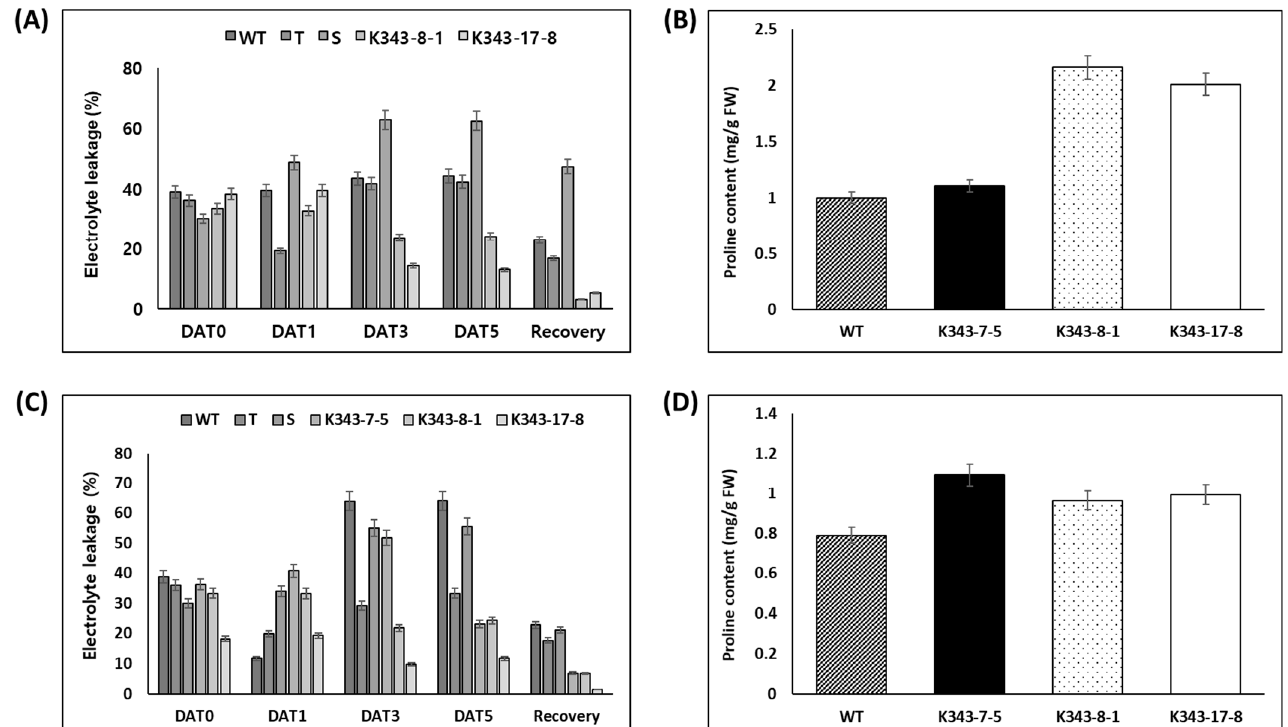
Figure 7. Determination of physiological traits in T 2 PUB7-GE during drought and salinity stress treatment. ( A ) Ion leakage levels (%) were measured after 5 days of drought stress treatment and after 3 weeks of recovery in WT and PUB7-GE. ( B ) Proline contents (mg/g FW) of WT and PUB7-GE after drought treatment ( C ) Ion leakage levels (%) were measured after 5 days of salinity stress treatment and after 2 weeks of recovery in WT and PUB7-GE. ( D ) Proline contents (mg/g) of WT and PUB7-GE after salinity treatment. Three replicates were used, and data are shown with SE.